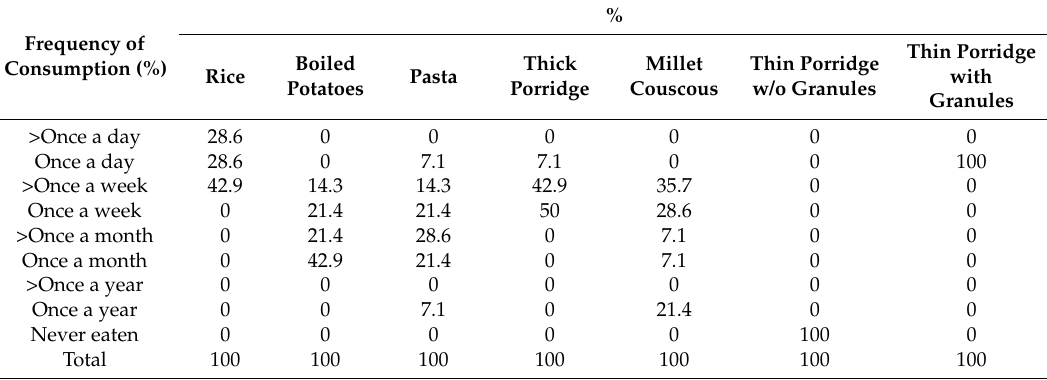
Table 1. Frequency (%) of consumption of the different test meals ( n = 14).